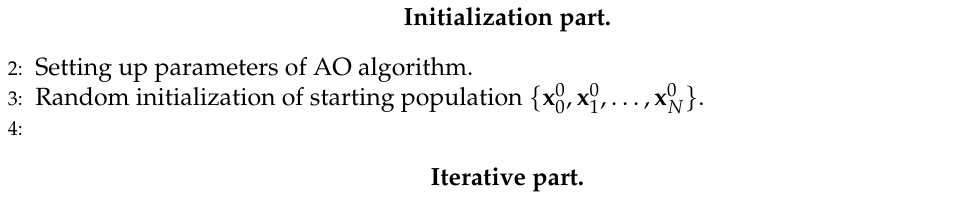
Algorithm 1 Aquila Optimize (AO)